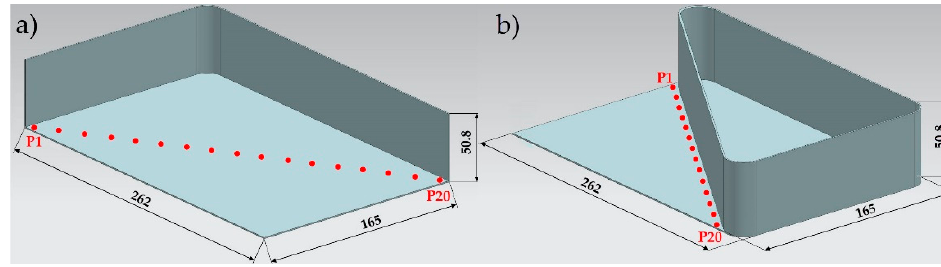
Figure 7. Absolute deformation measurements ( a ) of an element with walls arranged with a semi- open structure and ( b ) of an element with walls arranged with a closed structure.